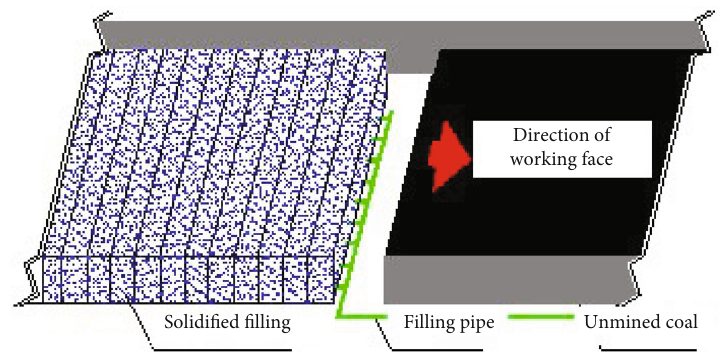
Figure 3: Schematic diagram of longwall paste fi lling working face.